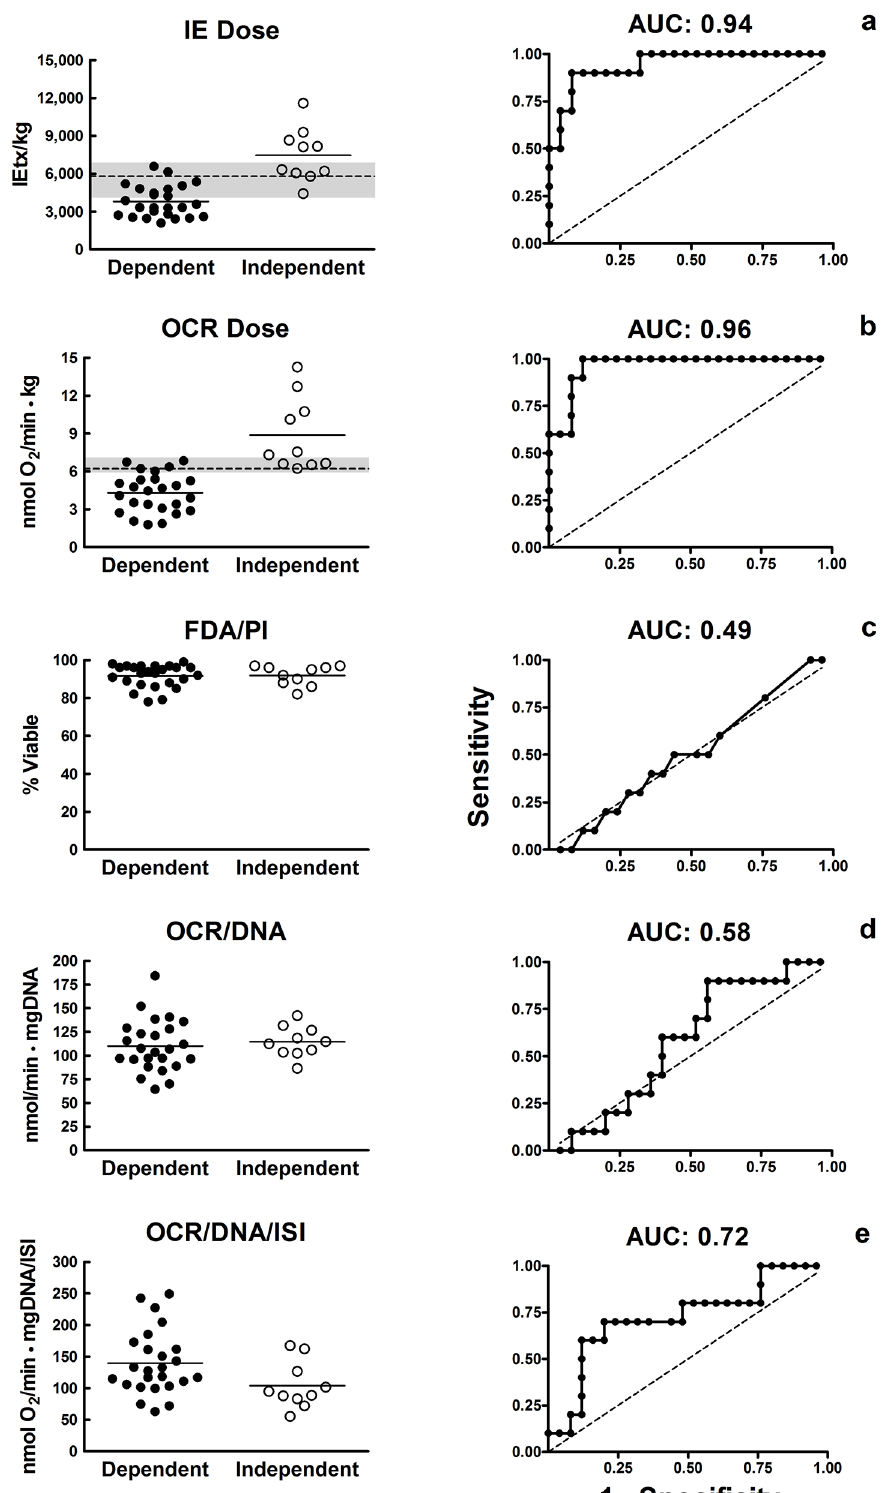
Fig 2. Overlap and correlation of islet characterization methods with clinical transplant outcome. Data from our study illustrating that membrane integrity staining (based on FDA/PI), oxygen consumption rate (OCR) normalized to DNA content (OCR/DNA), and OCR/DNA normalized to the islet size index (ISI) (OCR/ DNA/ISI) are not correlated with the clinical outcome [insulin independence vs. dependence] at 6 – 12 months